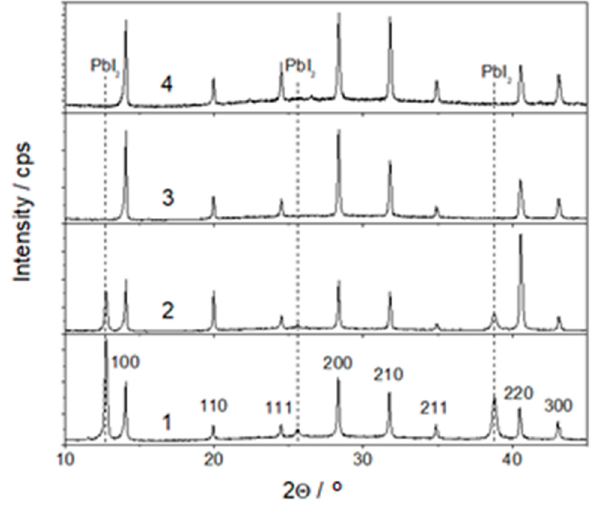
Figure 2. XRD patterns of perovskite layers with different content of Cs: 1—without Cs, 2—with 5, 3—with 10, 4—with 15% of Cs. The indexed peaks correspond to the perovskite phase FA 1/6 MA 5/6 PbBr 0.5 I 2.5 . Table 1. Values of the lattice parameter a and crystalite size D determined by the XRD.